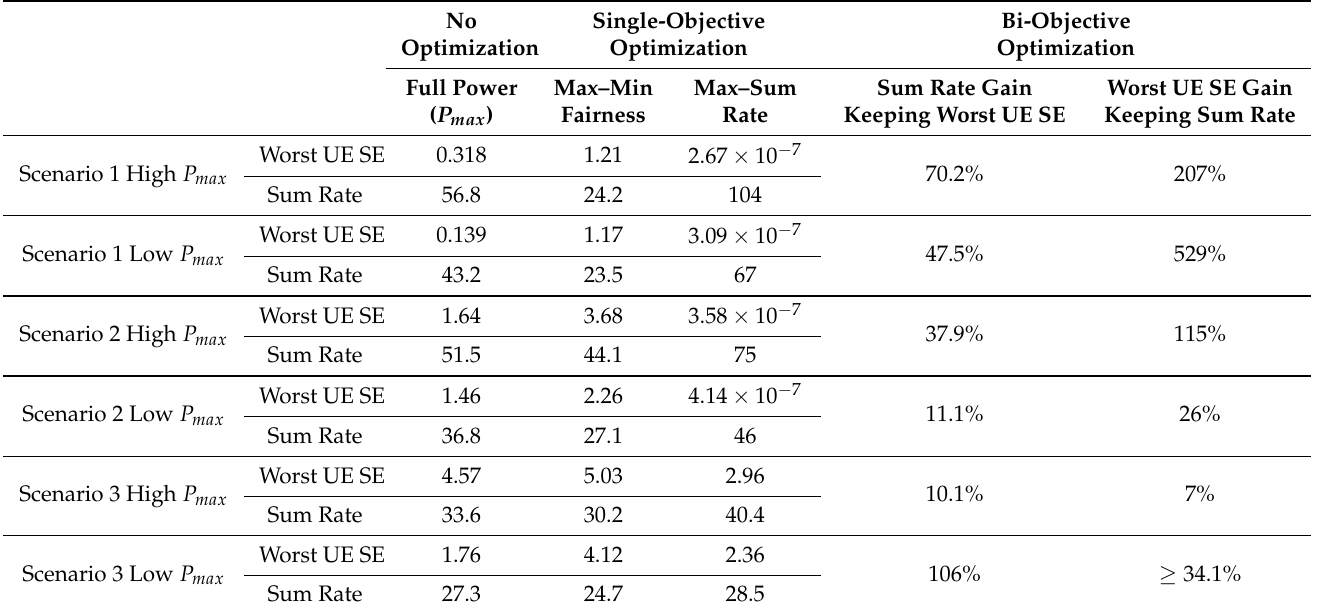
Table 3. SEs obtained through the optimization procedures in bit/s/Hz and the respective gains in %. No Single-Objective Bi-Objective Optimization Optimization Optimization Full Power Max–Min Max–Sum Sum Rate Gain Fairness Rate Keeping Worst UE SE Keeping Sum